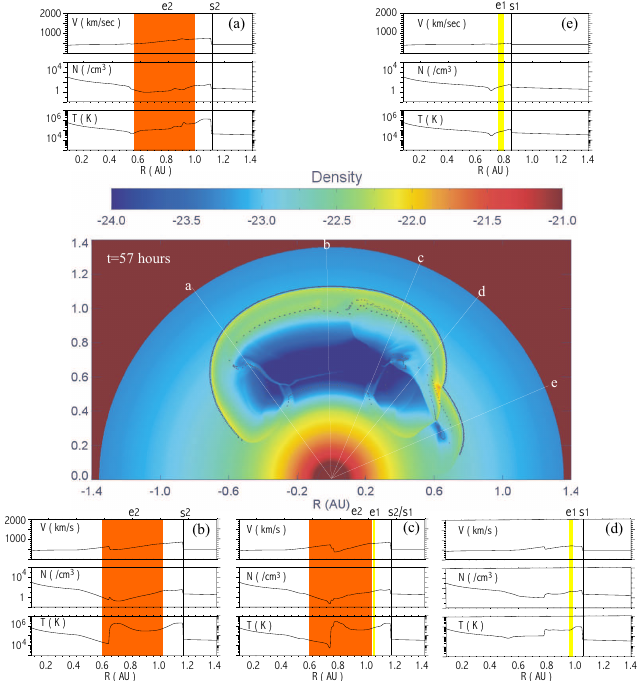
Fig. 8. Two-dimensional simulation. Snapshot of density logarithmic contours showing the evolution of the two ejecta at 57h after ejecta 1 initiation. Same format as the previous